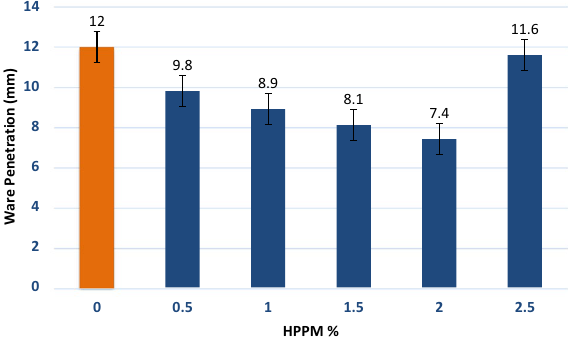
Figure 13 . Depth of water penetration versus HPPM fiber content after 28